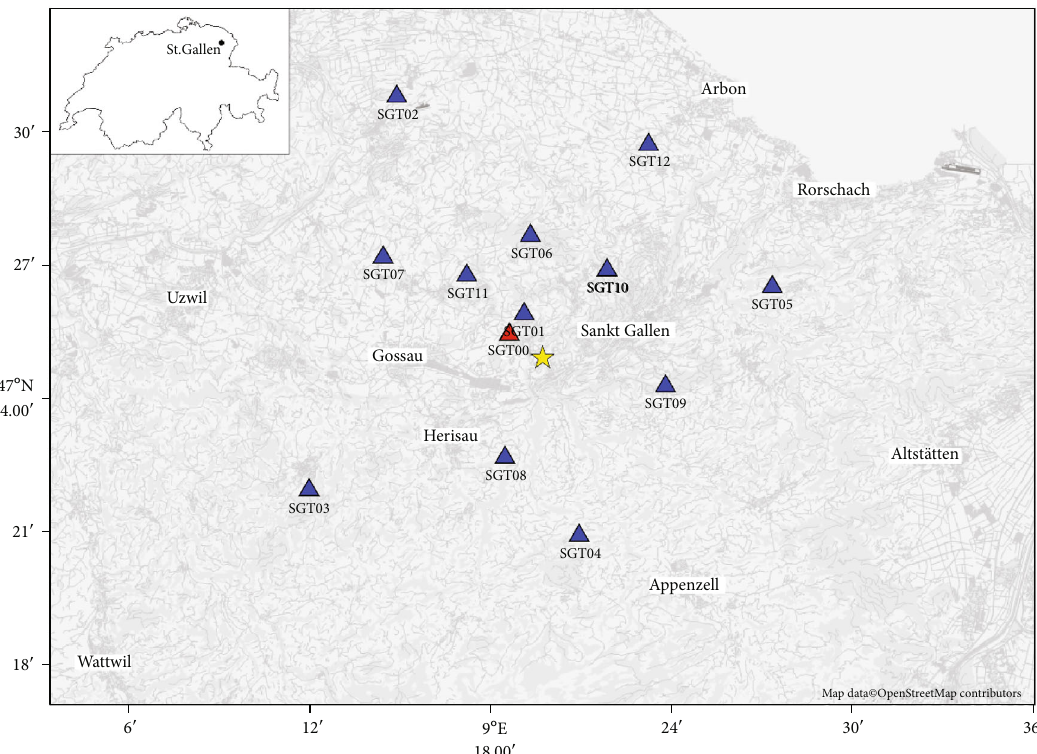
Figure 2: St. Gallen station network in map view. Wellhead position of injection well GT-1 is indicated by a yellow star. Blue triangles denote surface stations (SGT01-SGT12); red triangle denotes the instrument deployed in shallow borehole (SGT00). The position of the two accelerometers and the new position of station SGT06, SGT07, and SGT09 after slight relocation in October 2013 (renamed SGT13-17) are not shown. The inset in the upper left shows a map of Switzerland with the location of the St. Gallen project site. Data: [13, 14]. Map data from OpenStreetMap (published under